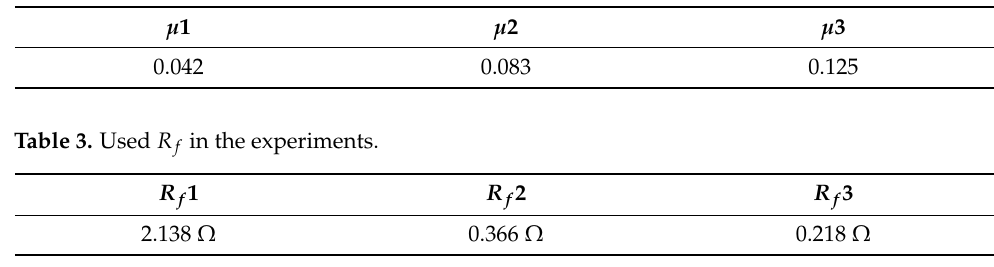
Table 2. Used µ in the experiments.